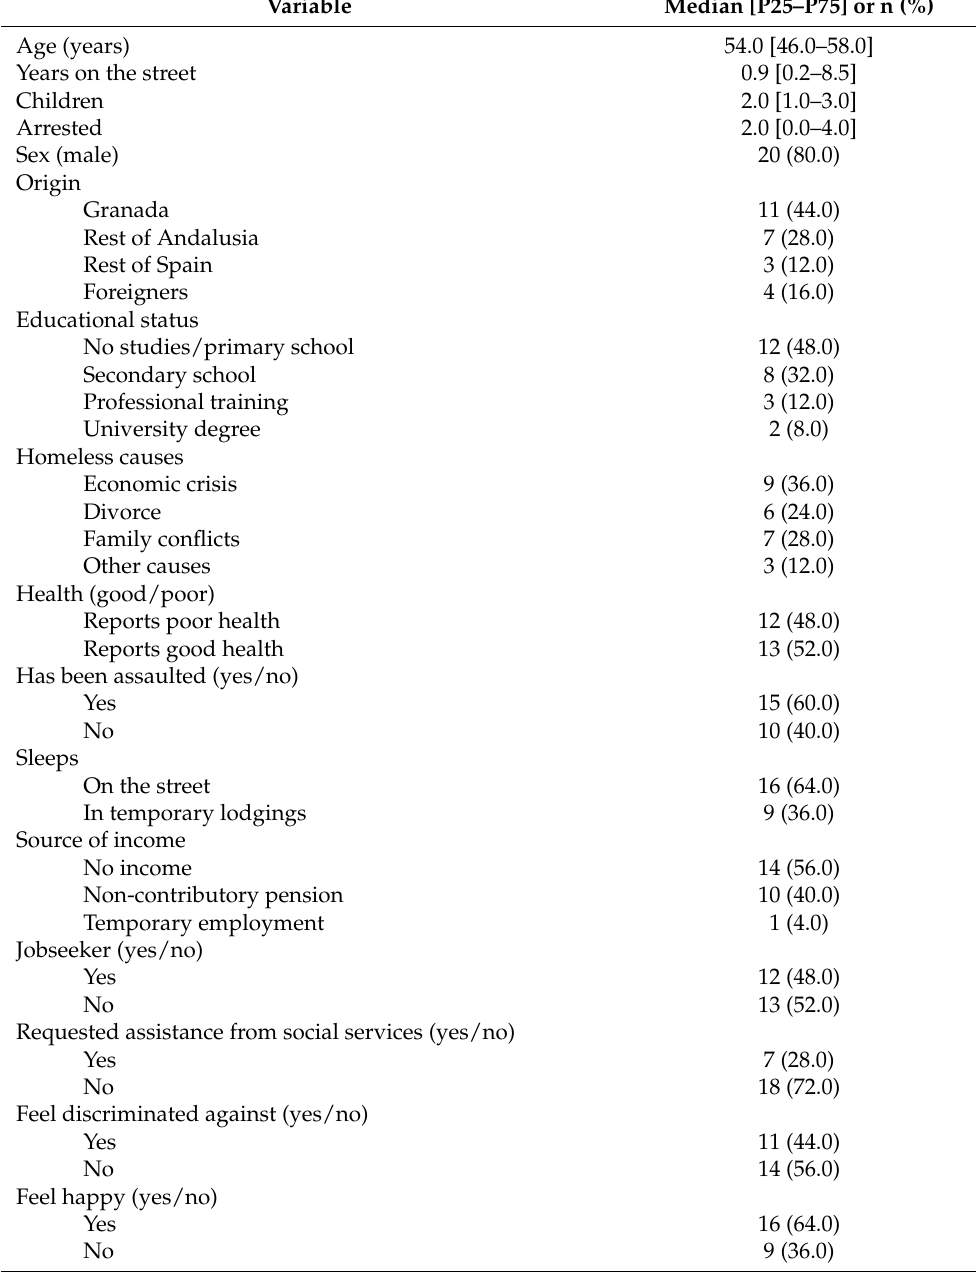
Table 1. Characteristics of the 25